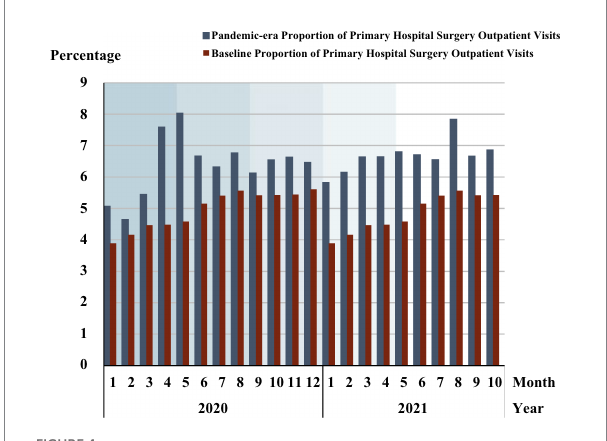
FIGURE 4 Proportion of surgery outpatients in primary hospitals. Each shadow area denotes COVID-19 phase 1 to phase 5.